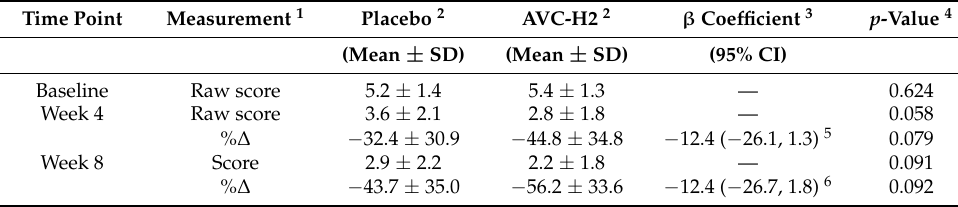
Table 6. VAS pain assessment scale from the baseline to the follow-up weeks.